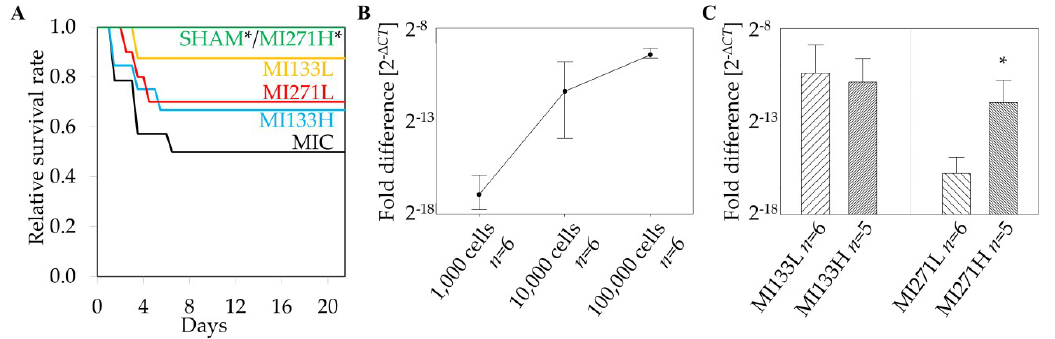
Figure 1. Therapy‐associated relative survival rates and stem cell retention. Significant survival rate for SHAM operated as well as high‐dose CD271 + stem cell treated mice (MI271H) compared to untreated myocardial infarction (MIC); * p = 0.03 vs. MIC (log‐rank test; ( A )). Detection threshold of 1000 cells using human GAPDH [24] ( B ). No significant difference between low and high‐dose CD133 + stem cell treatment in contrast to the MI271L/MI271H group 3 weeks post MI in mice; Mean±SD; * p ≤ 0.05 vs. MI271L (Mann–Whitney U test; ( C )).